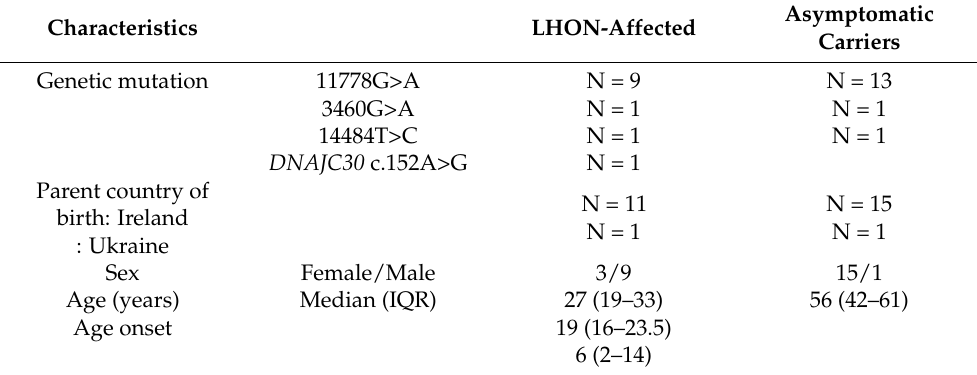
Table 1. Demographic and genetic analysis